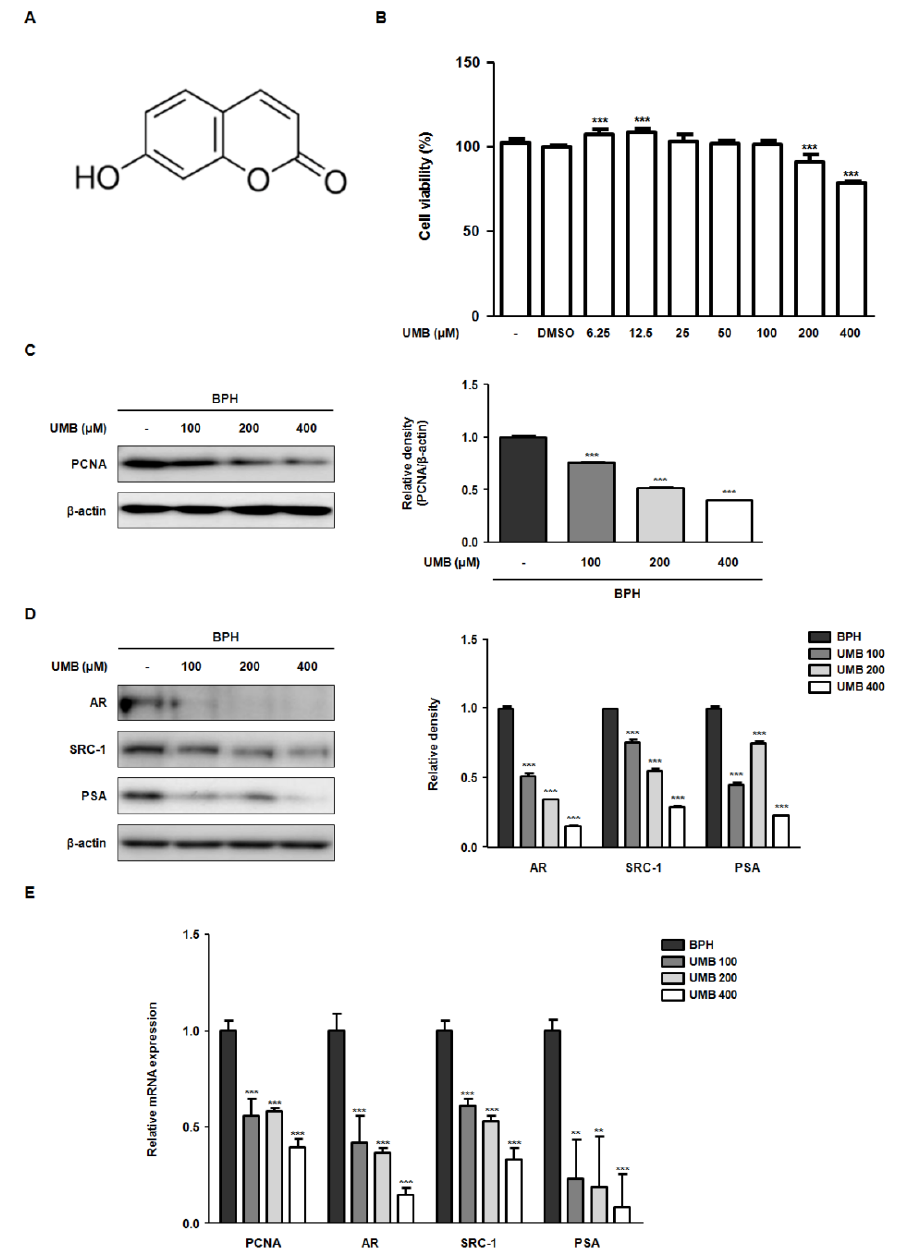
Figure 1. Effect of UMB on the blockade of androgen/AR signaling in BPH-1 cells. ( A ) Molecular structure of UMB. ( B ) BPH-1 cells were treated with or without different concentrations (6.25–400 μ M) of UMB for 24 h, and cell viability was assessed. ( C , D ) BPH-1 cells were treated with or without 100, 200, and 400 μ M of UMB. The protein expression of ( C ) PCNA, ( D ) AR, SRC-1, and PSA was determined by Western blot analysis using specific antibodies. The relative density of the proteins was normalized to that of β -actin, which was used as an internal control. ( E ) The mRNA expression of PCNA, AR, SRC-1, and PSA was quantified using qRT-PCR in BPH-1 cells. The relative mRNA expression was normalized using the Ct value of β -actin. The values represent as mean ± standard deviation (S.D.) of three independent experiments. ** p < 0.01, *** p < 0.001 vs. vehicle control.